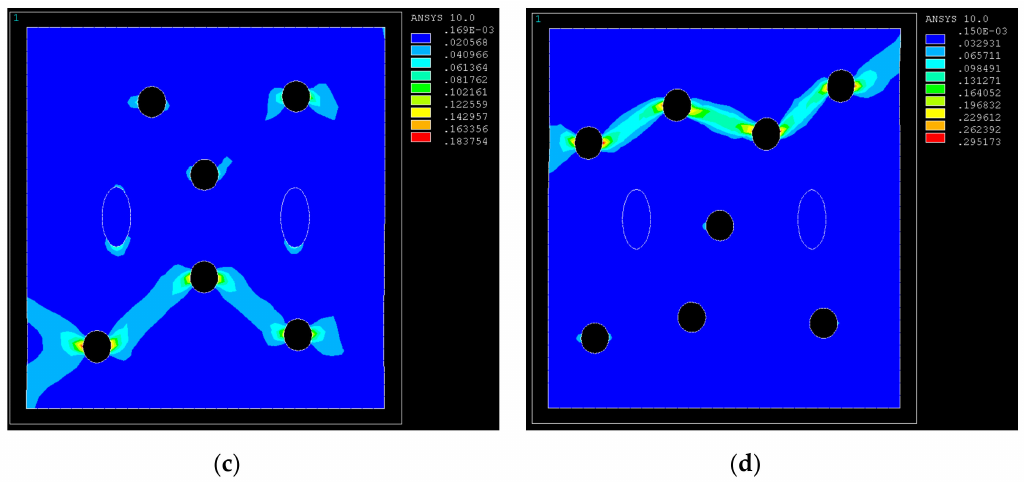
Figure 3. Strain diagram of GRANs with di ff erent porosities, ( a ) 1.2%, ( b ) 2.4%, ( c ) 3.6%, and ( d ) 4.8%.